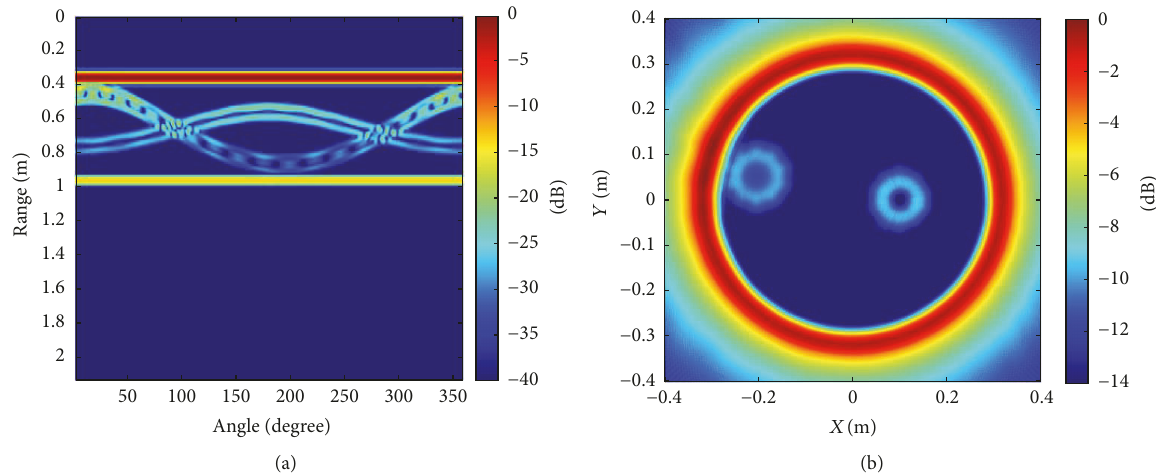
Figure 3: Simulation results for the geometry in Figure 2: (a) range-angle image; E s (𝑟, 𝜙) , (b) focused image; I (𝑥,𝑦) after applying our algorithm.